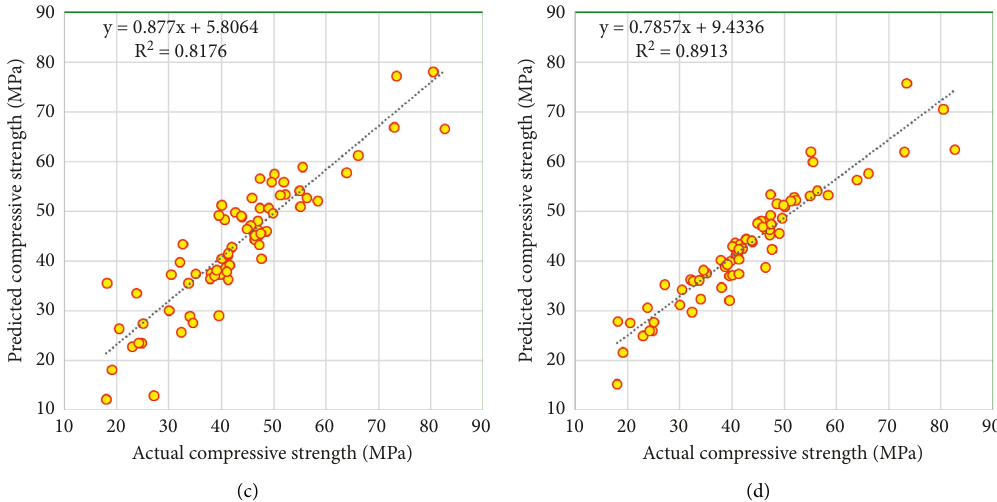
Figure 9: Scatter plot presentation using the developed AI model and for (80%-20%) data division scenario. (a) DLNN model. (b) MARS model. (c) ELM model. (d) RF model.